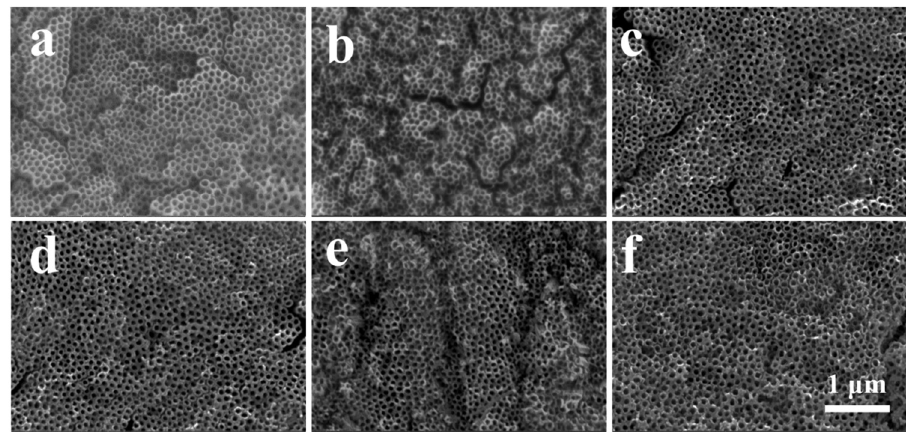
Figure 1: Surface morphologies of ( a ) TNT, ( b ) TNTA, ( c ) TNTA – Dopa, ( d ) TNTA – Dopa – Cu – Sr0.5, ( e ) TNTA – Dopa – Cu – Sr1, and ( f ) TNTA – Dopa – Cu –